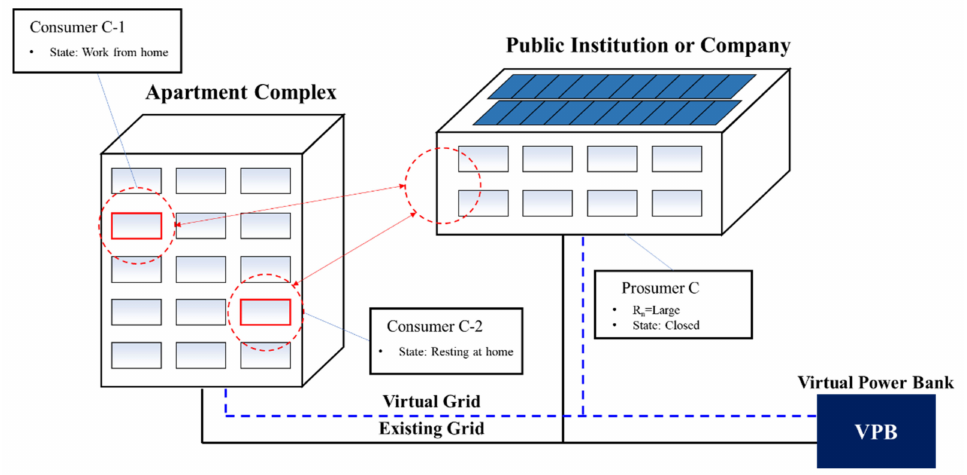
Figure 8. Surplus electricity trading model caused by public institution closure due to